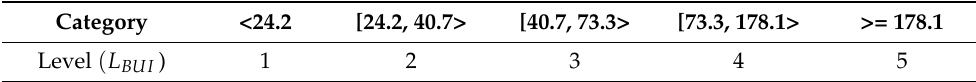
Table 1. Buildup Index (BUI) categories [47].